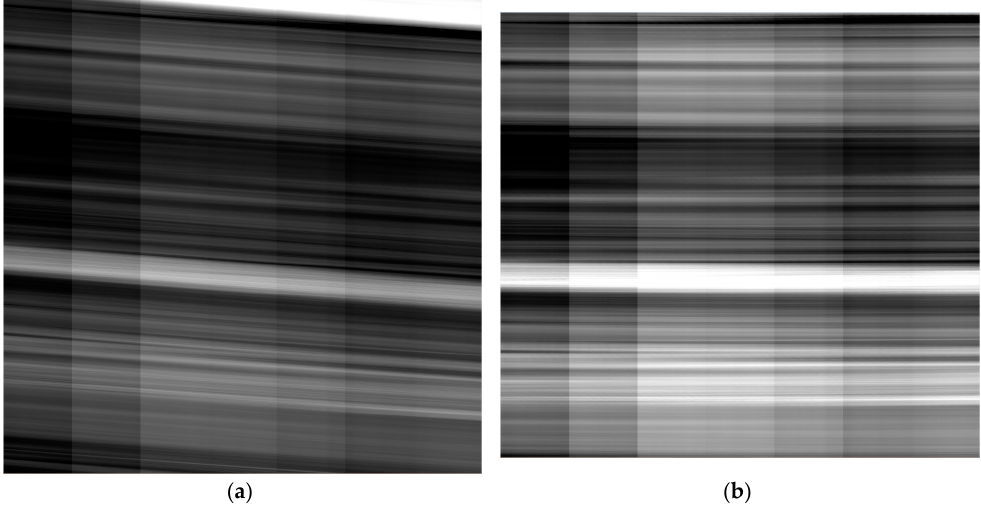
Figure 16. The results of data pre-processing. ( a ) The primary image was obtained using Equation (4) with raw side-slither data; ( b ) The standard image is the result of standard correction of the primary image.